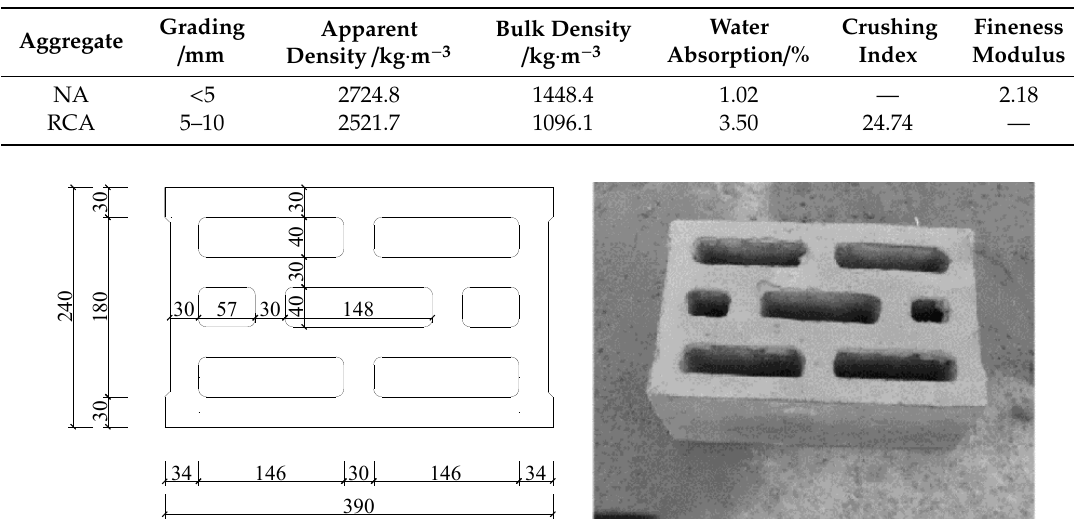
Table 2. Properties of aggregates. Table 1. Composition of recycled concrete block.